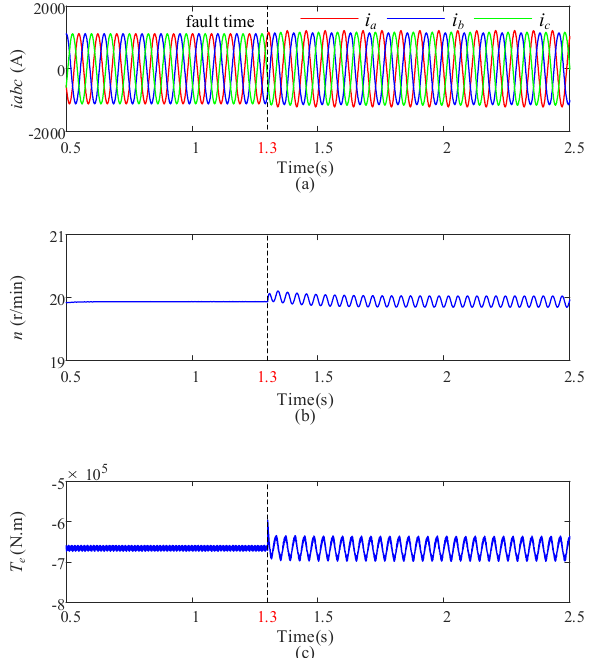
Figure 6. Simulation results. ( a ) Three-phase current of stator; ( b ) speed; ( c ) electromagnetic torque. The waveforms of current residuals on dq -axis are shown in Figure 7a–c is the spectrum of current residuals after the fault. Under normal conditions, the current residuals are almost equal to zero, so the spectrum analysis of the signal before the fault is not very meaningful. After the fault, obvious dc component and second harmonics appear in the residuals. The second harmonic on d -axis and q -axis have almost the same amplitude, while the difference between dc components is mainly related to the fault location, which is consistent with the theoretical analysis result of Equation (23)